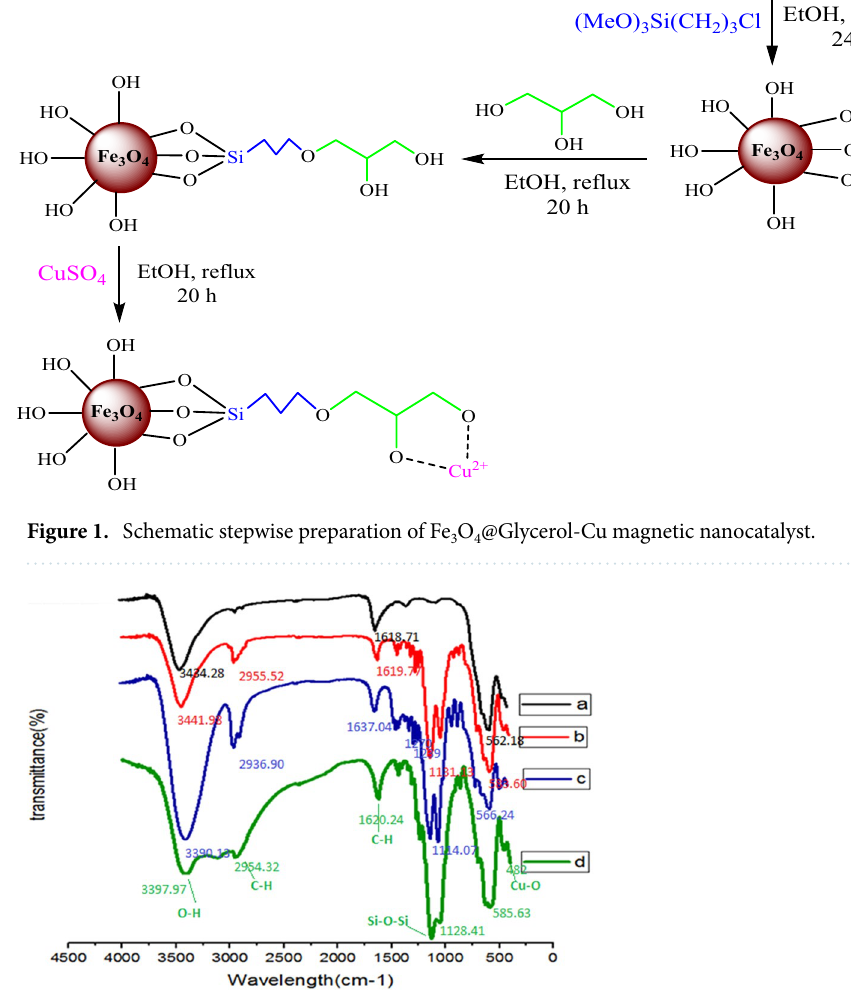
FT‑IR analysis. Figure 2, illustrates the FT-IR spectra acquired for Fe 3 O 4 (curve a), MNP–(CH 2 ) 3 Cl (curve b), MNP–(CH